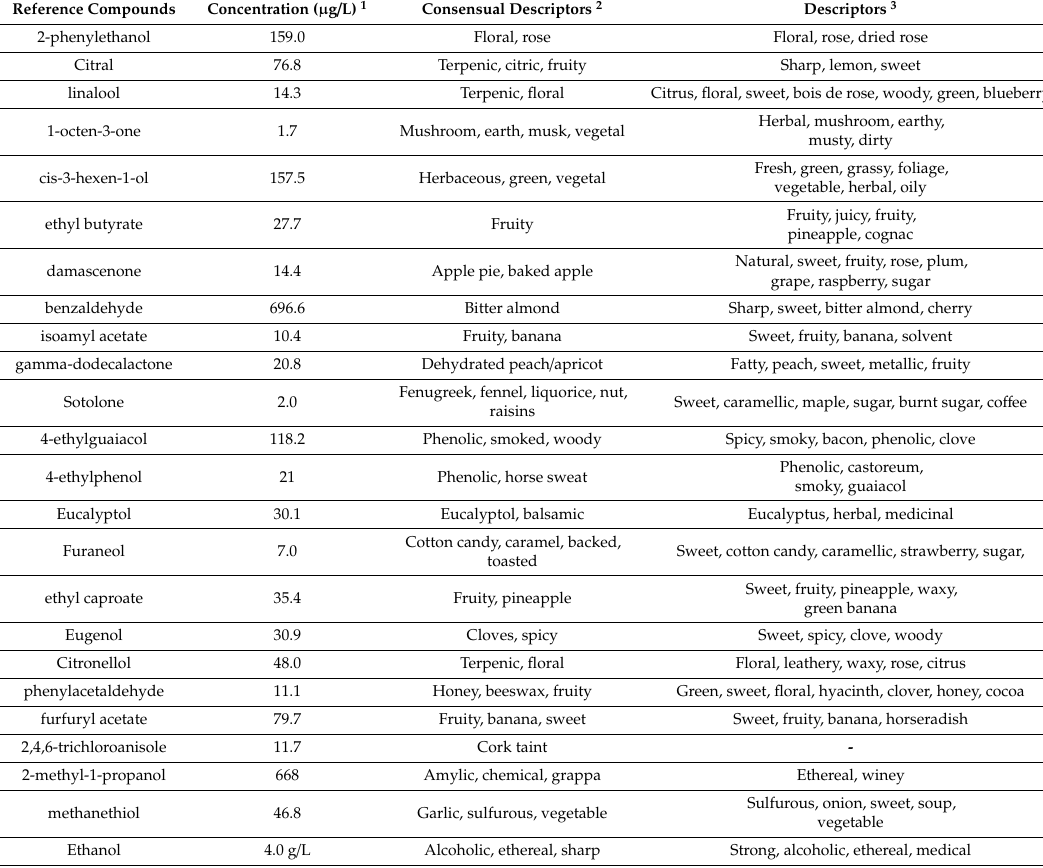
Table 1. Standards and descriptors used to train the assessors in recognizing / distinguishing